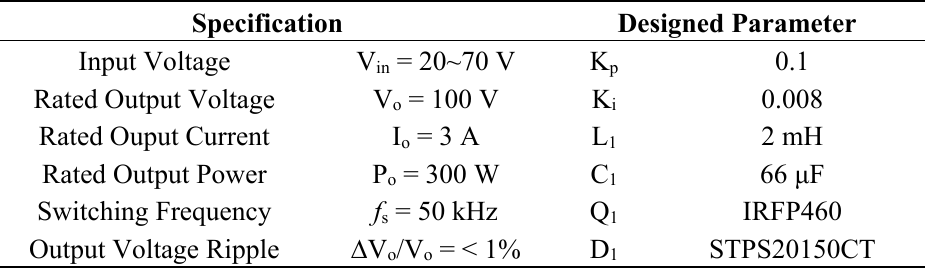
Table 3. Specification of the utilized boost